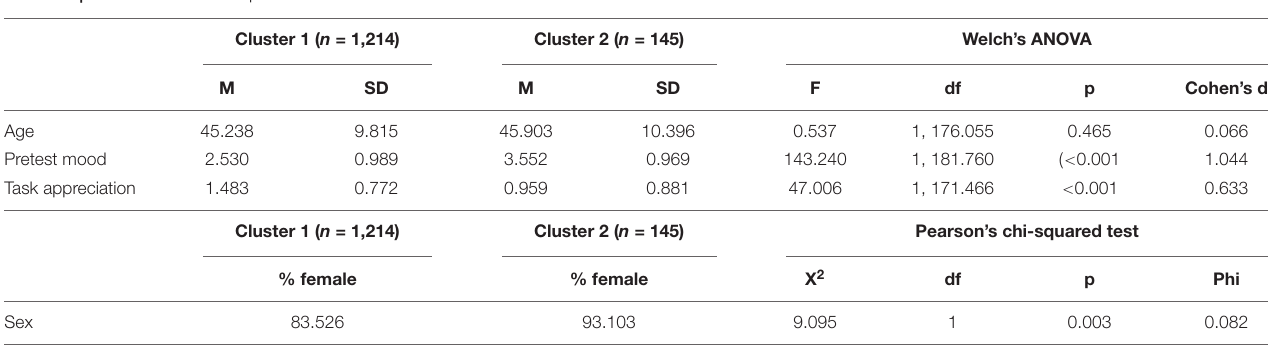
TABLE 3 | Between-cluster comparisons.